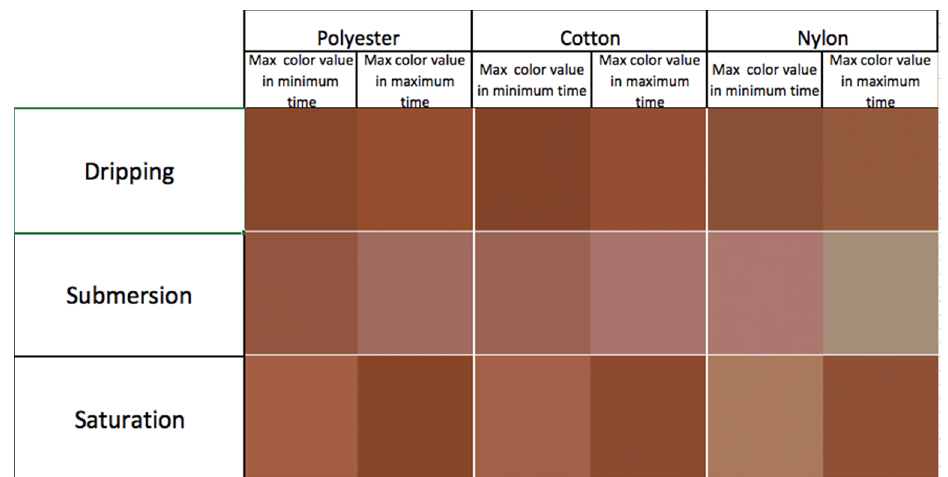
Figure 2. Visual representation of the highest delta E values (max color) for all fabric types across all test types, to show fading. “Minimum time” represents the initial color of the textile upon the pigment being applied, and “maximum time” represents the final color on the last day of evaluation (one week).